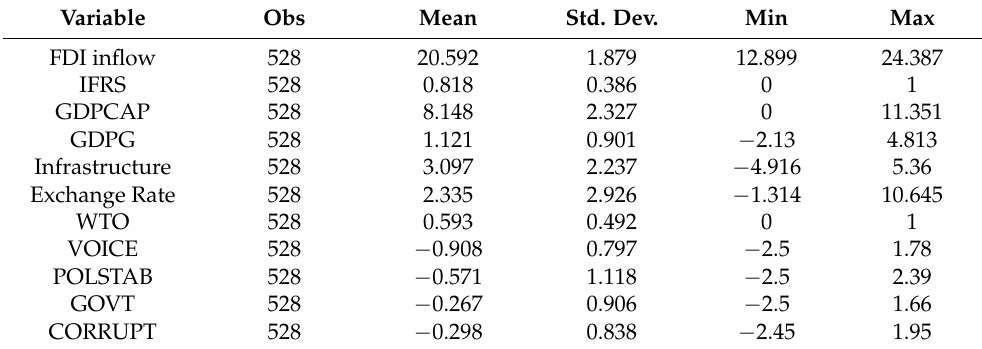
Table 1. Summary